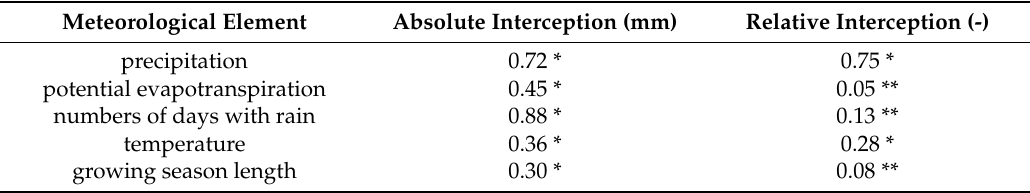
Figure 7. Relationship between relative growing season interception and: ( a ) sum of precipitation; ( b ) sum of potential evapotranspiration; ( c ) number of days with rain; ( d ) mean temperature; ( e ) length of the growing season. Table 3. Correlation coefficients for relation between growing season interception (absolute and relative) and meteorological elements.